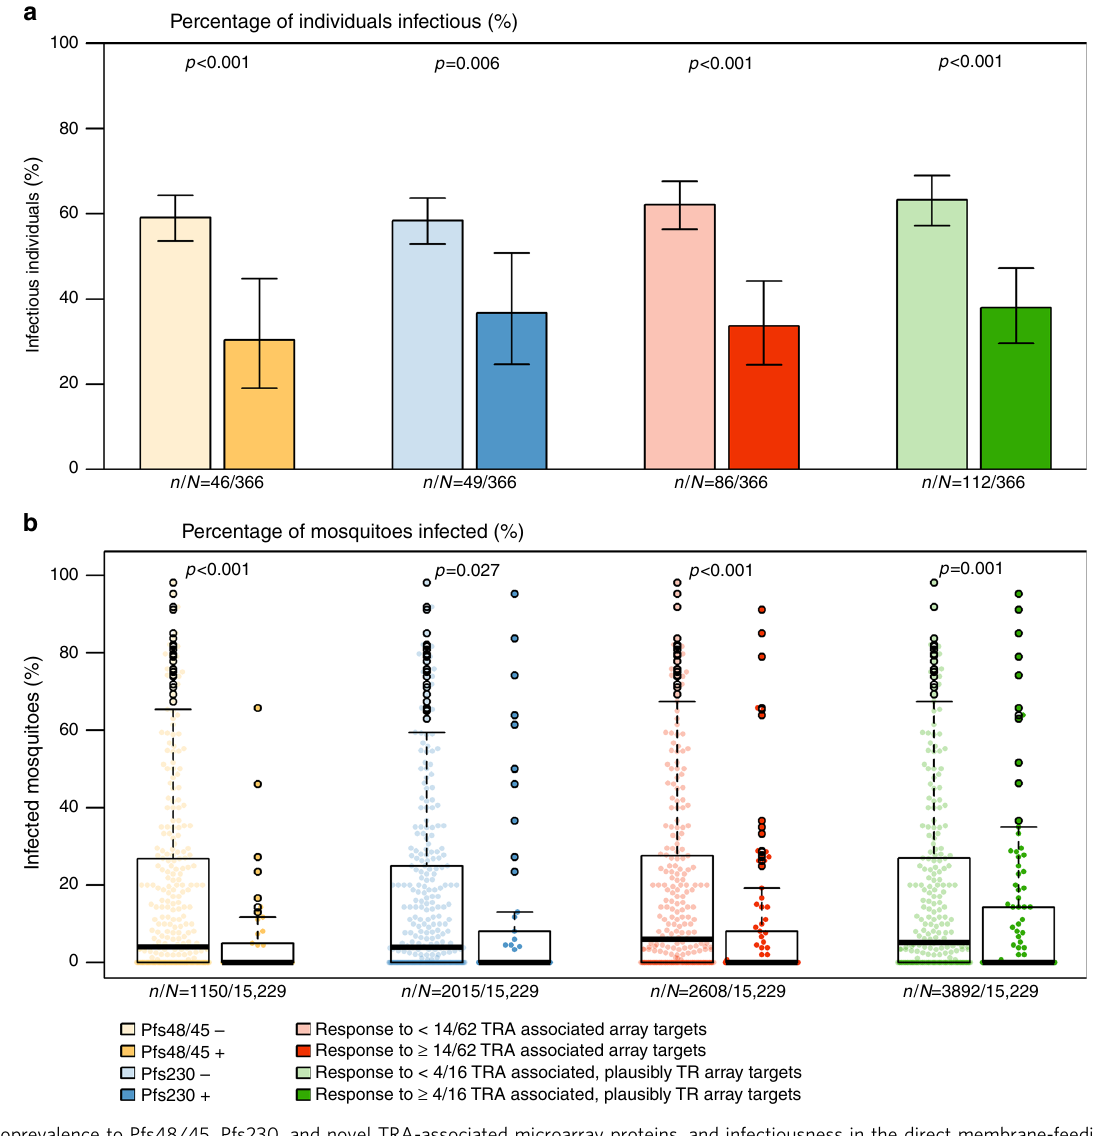
con fi rmed the absence of these proteins on Pfs48/45 KO gamete surfaces (Fig. 4). The immuno- fl uorescence of gamete surfaces observed using total IgG and IgG depleted of α -Pfs48/45 and α - Pfs230 antibodies from naturally exposed individuals therefore re fl ects recognition of unknown antigens on the gamete surface (Fig. 4; Supplementary Fig. 5A).